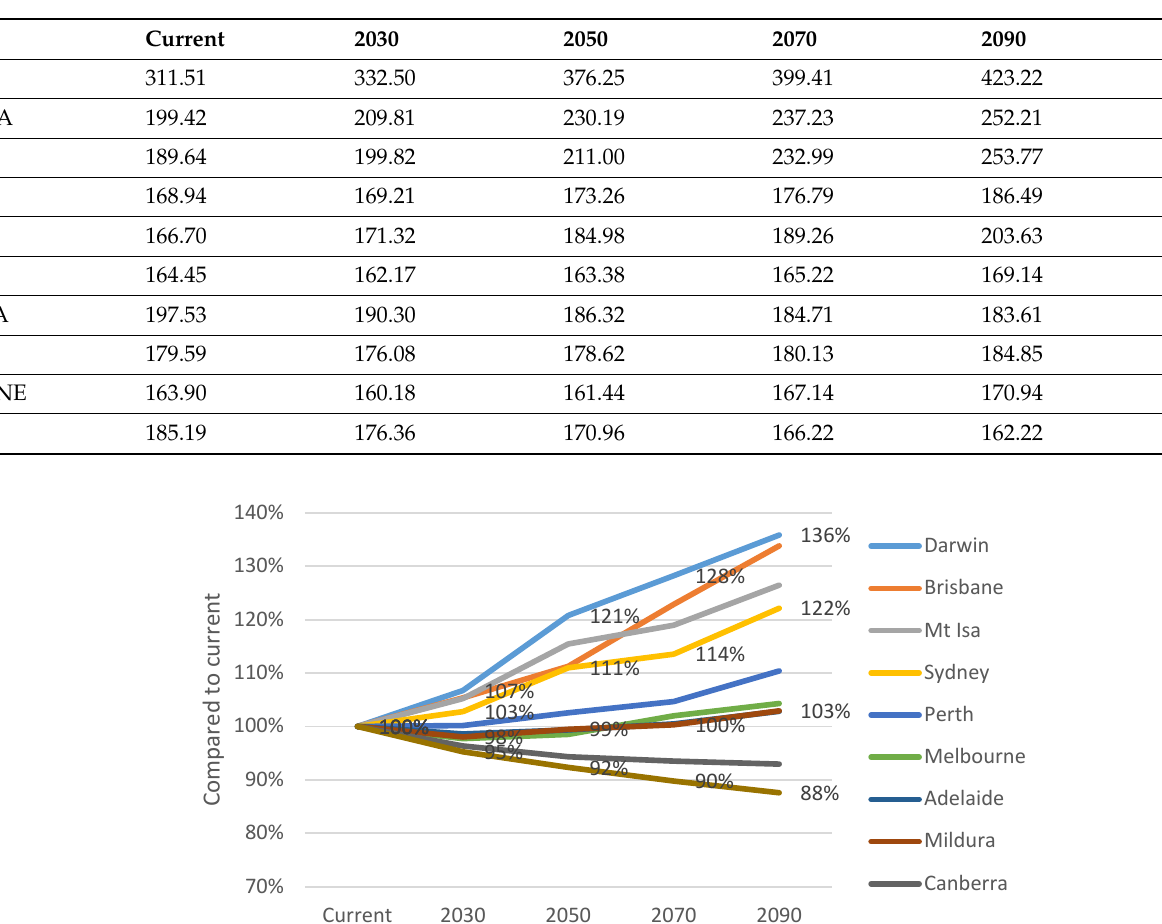
Figure 10. Small hospital’s yearly HVAC energy use benchmarking.